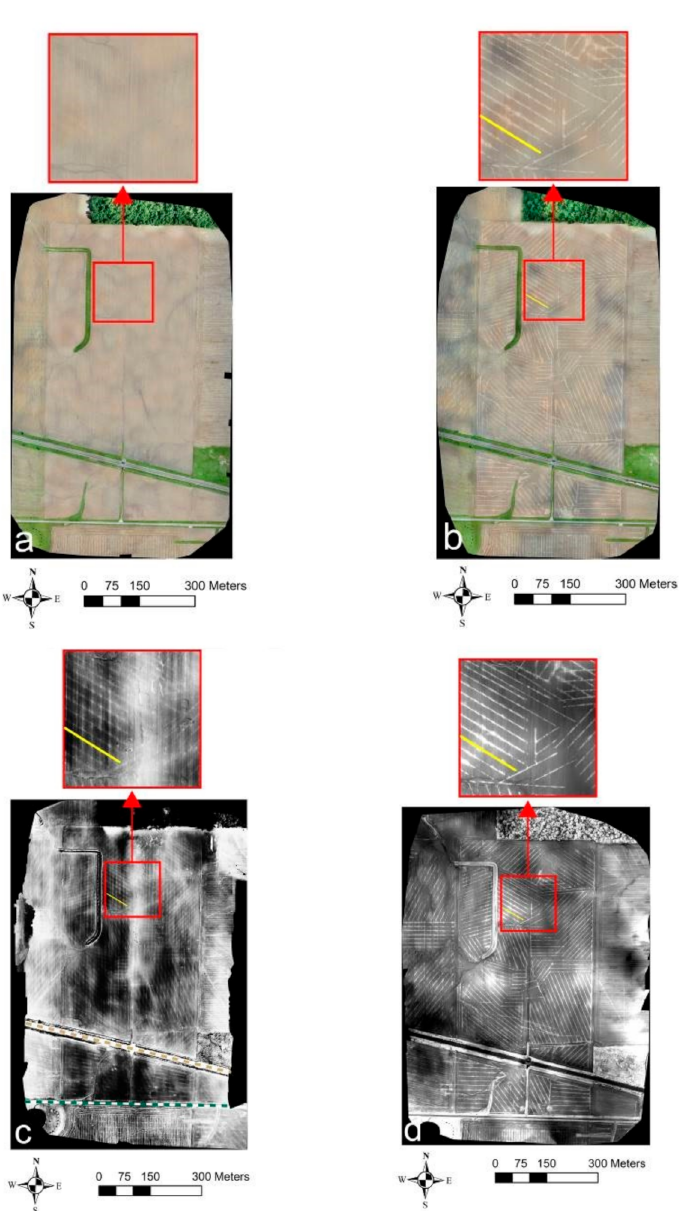
Figure 10. Site-4 UAV survey results from 21 June 2019: ( a ) VIS-C 1, ( b ) VIS-C 2, ( c ) TIR, and ( d ) red edge orthomosaic imagery. Solid yellow lines indicate the drain lines’ directional trend. The first set of UAV surveys with the VIS-C and MS camera payloads was performed approximately at 10:30 a.m., while the second set was performed seven hours later. The UAV TIR survey was performed between 11:00 and 11:30 a.m. Railway crossing and a county road are highlighted, respectively, by brown and green dashed lines in 10c. Part of the results (10a and b) was presented in